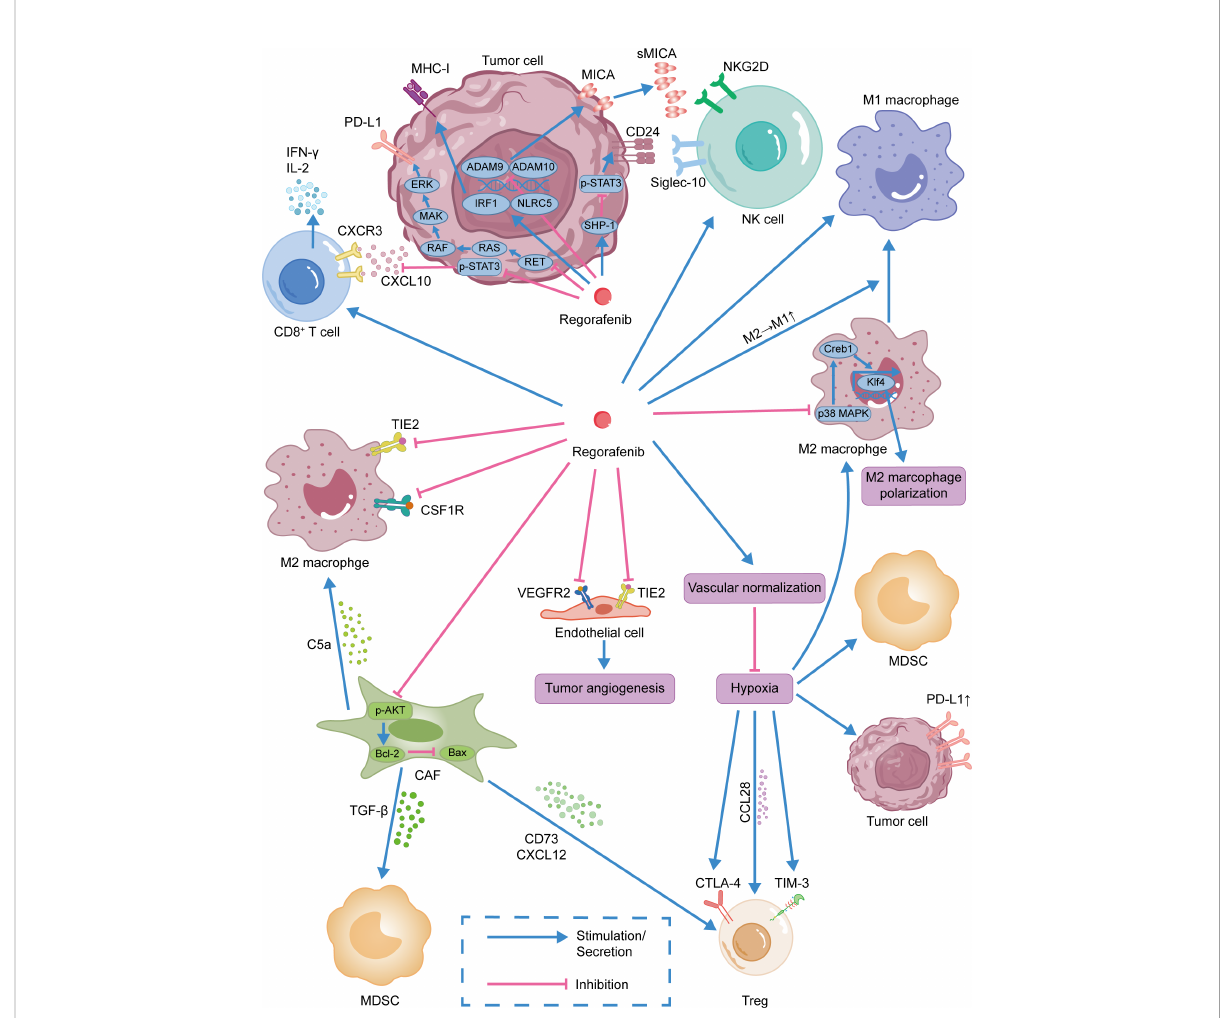
FIGURE 1 Immunomodulatory effect of regorafenib.Regorafenib was shown to promote the in fi ltration of CD8 + T cells into tumor tissues and activate NK cells. By normalizing tumor blood vessels, regorafenib improves the immunosuppressive tumor microenvironment. Moreover, regorafenib was also shown to inhibit MDSCs, CAFs, and Tregs and promote the repolarization of TAMs from M2-like to M1-like phenotype.